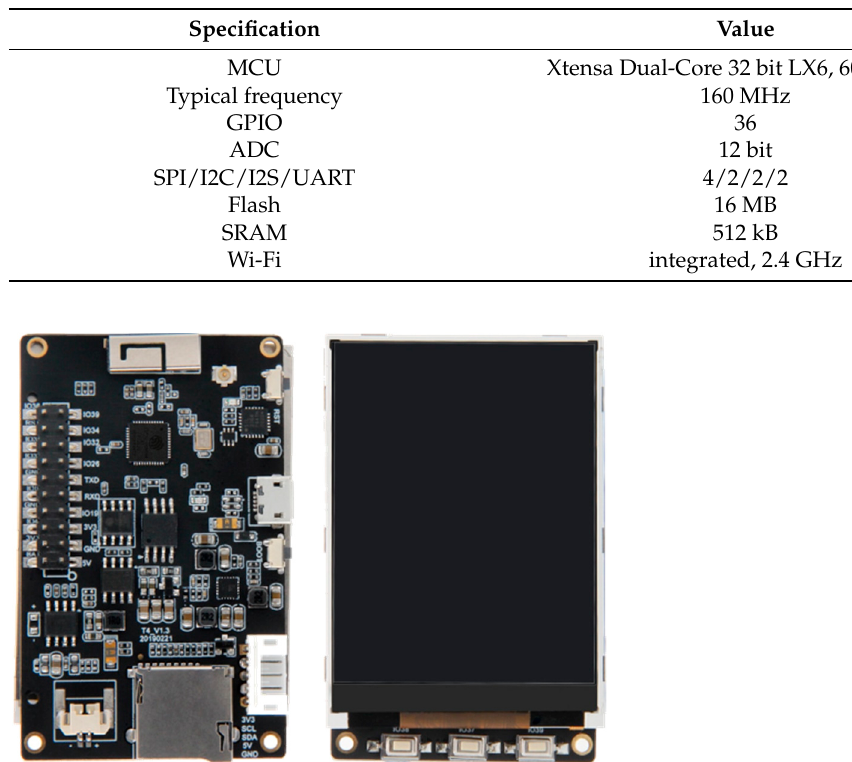
Figure 3. ESP-32 based module with integrated LCD.